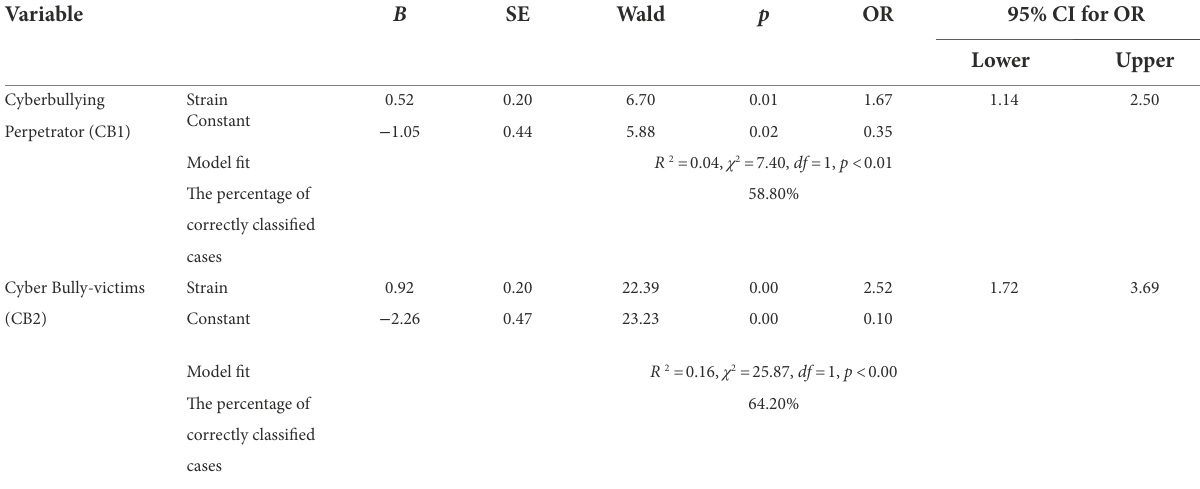
TABLE 2 Results of the binary logistic regression analysis of low self-control, strain, and cyberbullying.